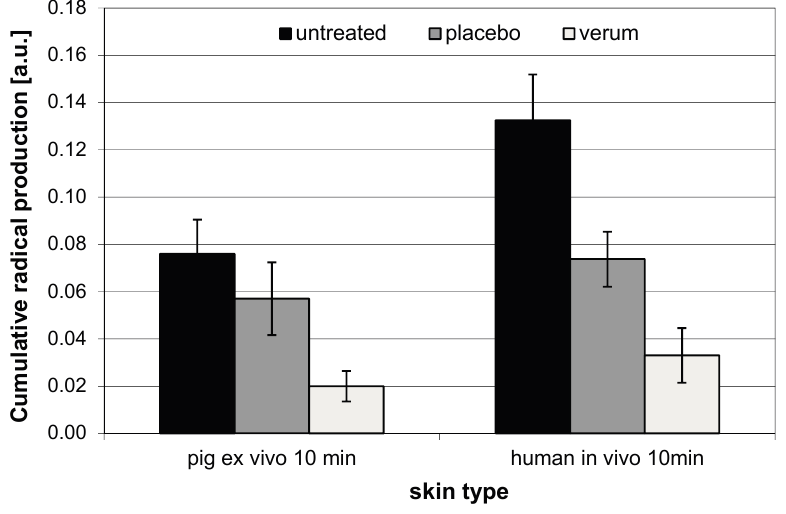
Figure 5. Cumulative radical production in excised pig ear and human in vivo investigations. Modified and reproduced with permission from [64], published by John Wiley and Sons,